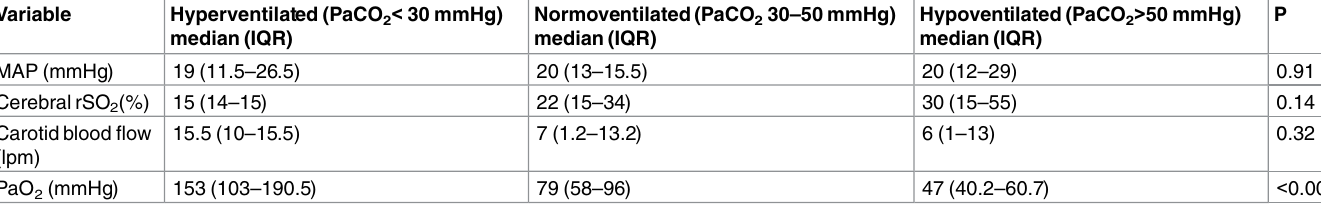
Table 3. Variables comparison betweenventilation status.